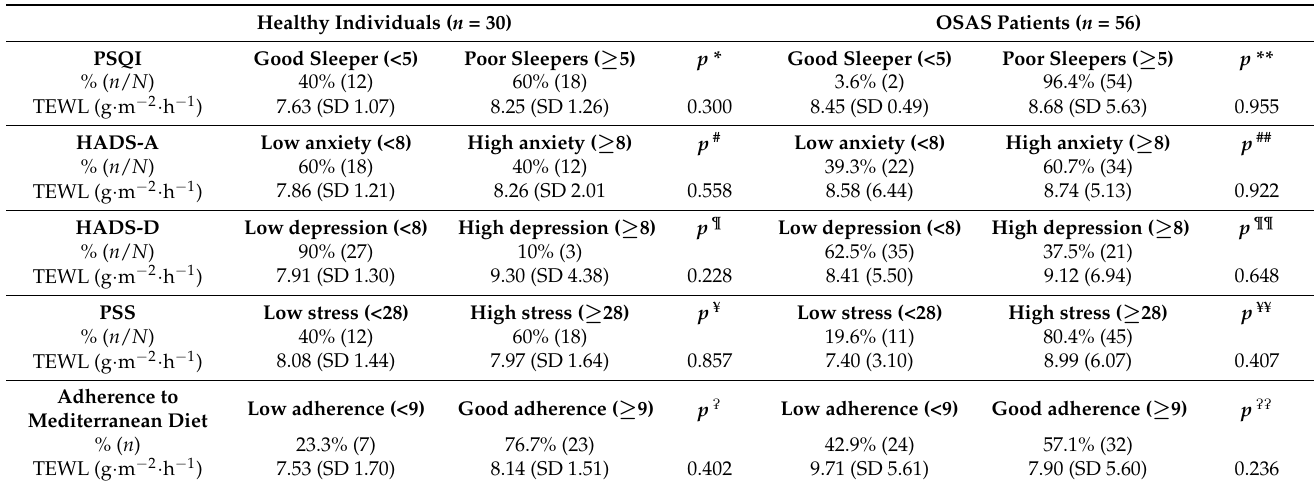
Table 5. TEWL values depending on exposome